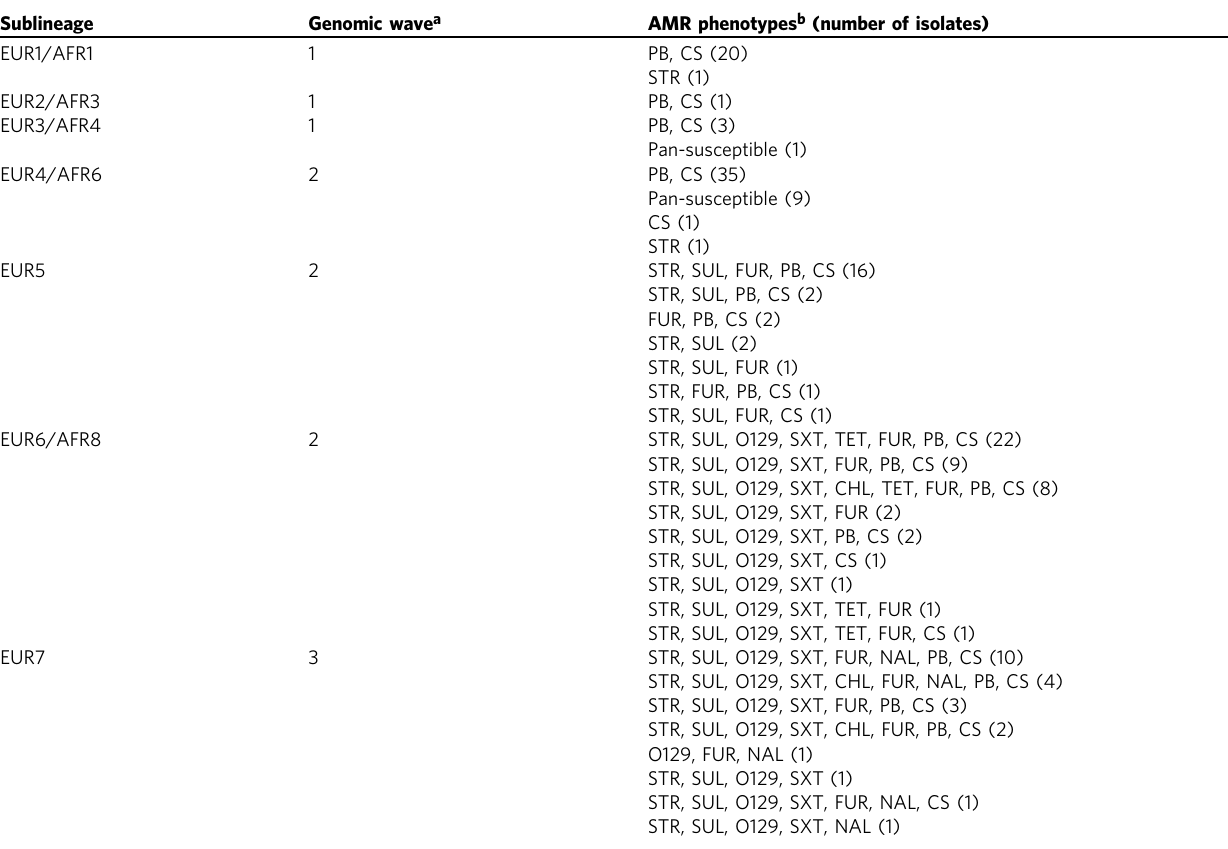
Table 6 Antimicrobial resistance phenotypes of 167 European V. cholerae O1 El Tor isolates, according to their phylogenetic